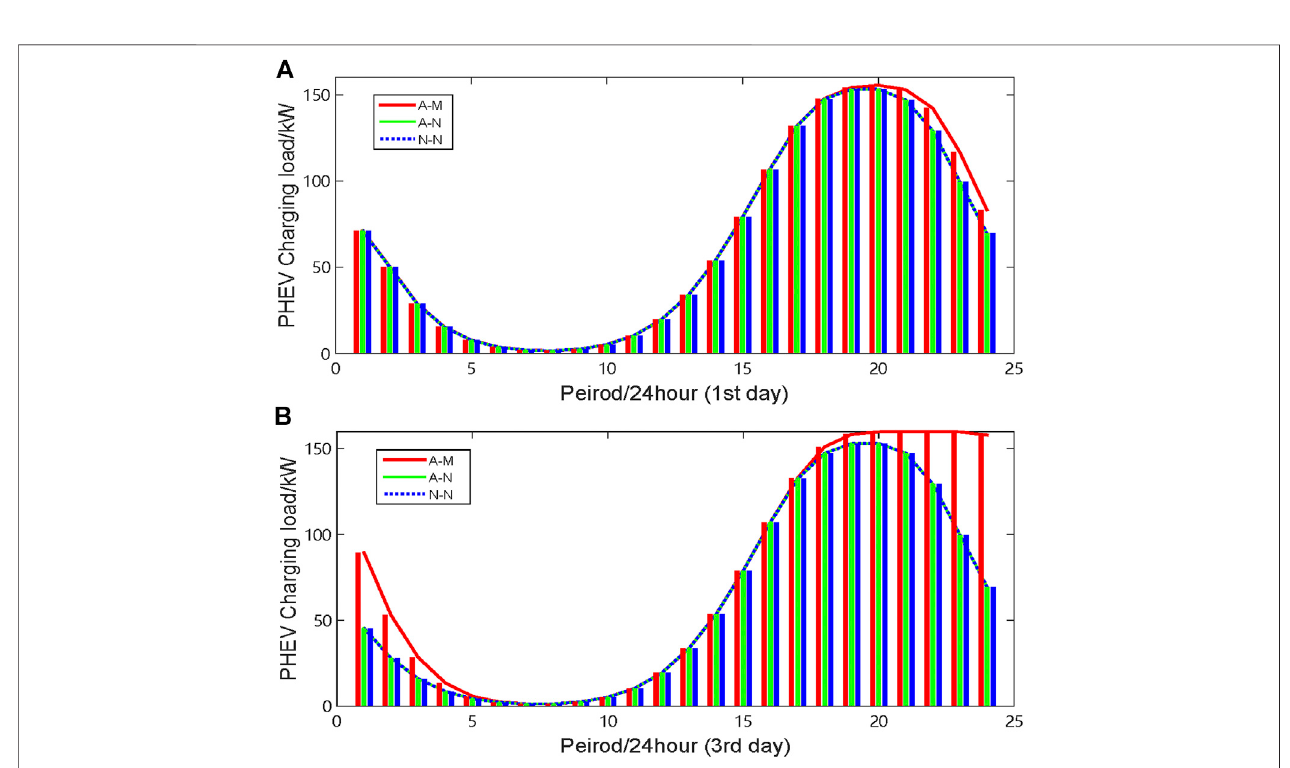
FIGURE 10 | Load variation of charging station D. (A) Charging load in the fi rst 24 h (1 st day). (B) Charging load in the third 24 h (3 rd day).